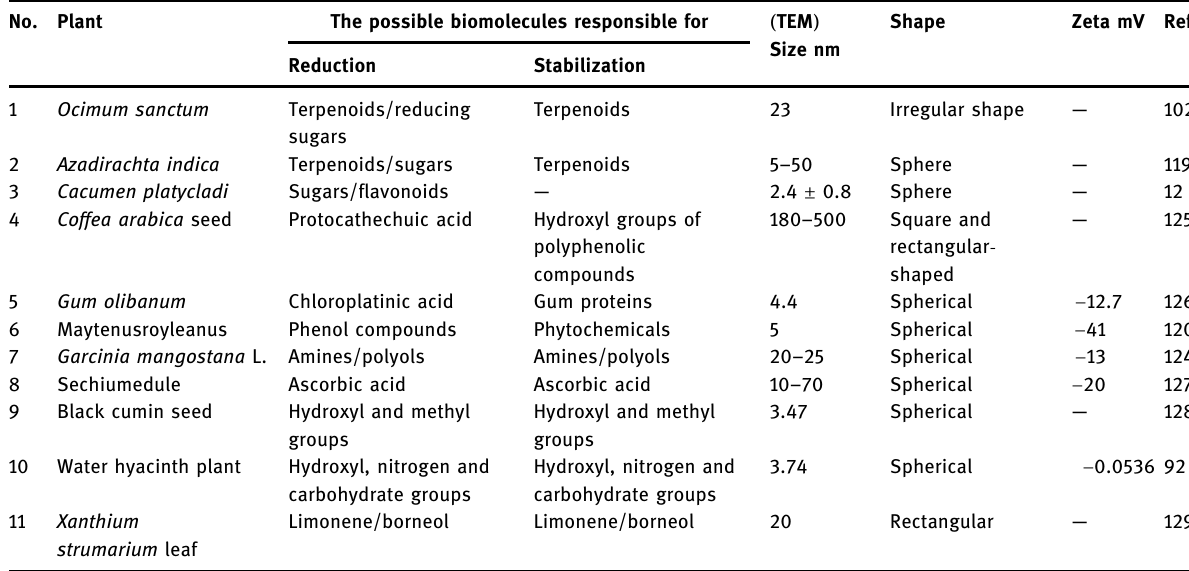
Table 1: Studies of the in fl uence of various plant on size, shape, and stabilization of Pt NPs No. Plant